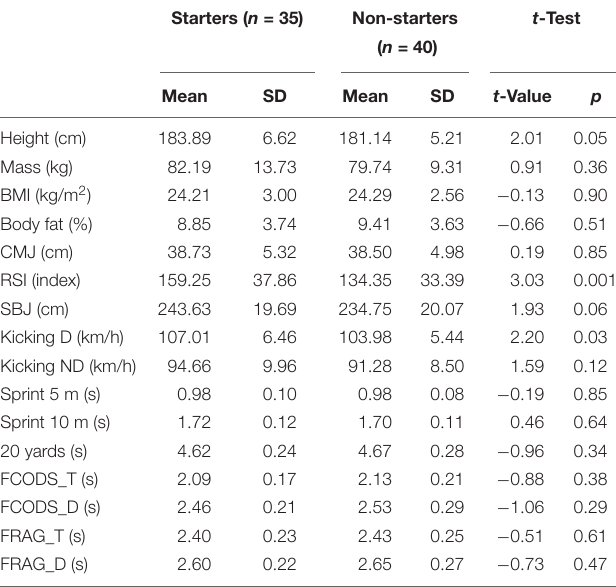
TABLE 2 | Univariate differences between starters and non-starters in studied variables ( t -test for independent samples). Starters ( n = 35) Non-starters t